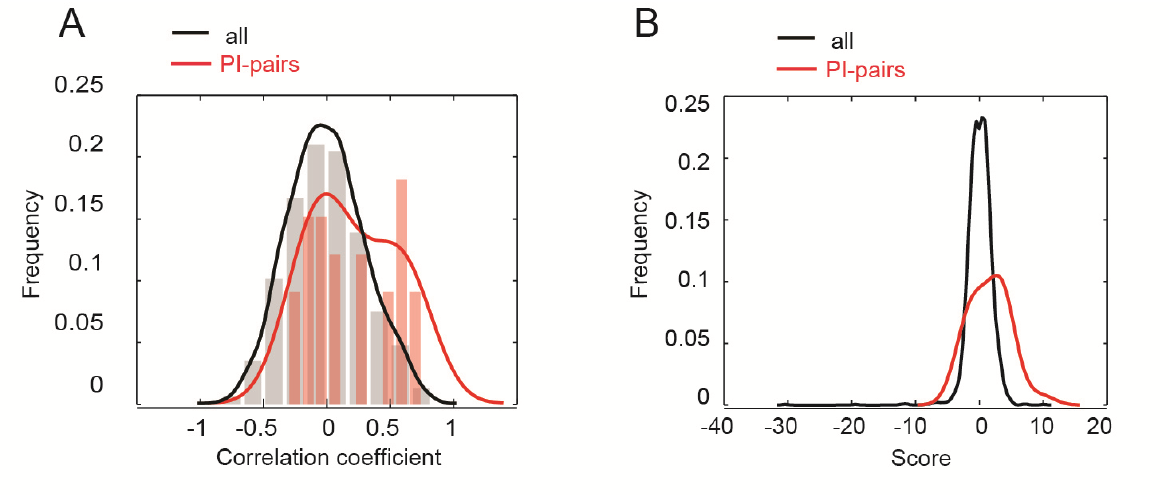
FIGURE 4: Relationship between genetic and physical interactions. (A) Distribution of correlation coefficients for all gene pairs (black line) and physically interacting (PI) pairs (red line). (B) Distribution of genetic interaction scores for all gene pairs (black line) and physi- cally interacting (PI) pairs (red